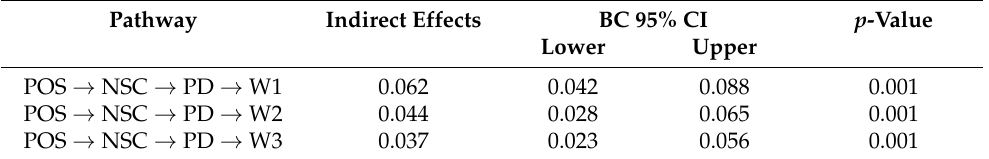
Table 5. Mediation analysis